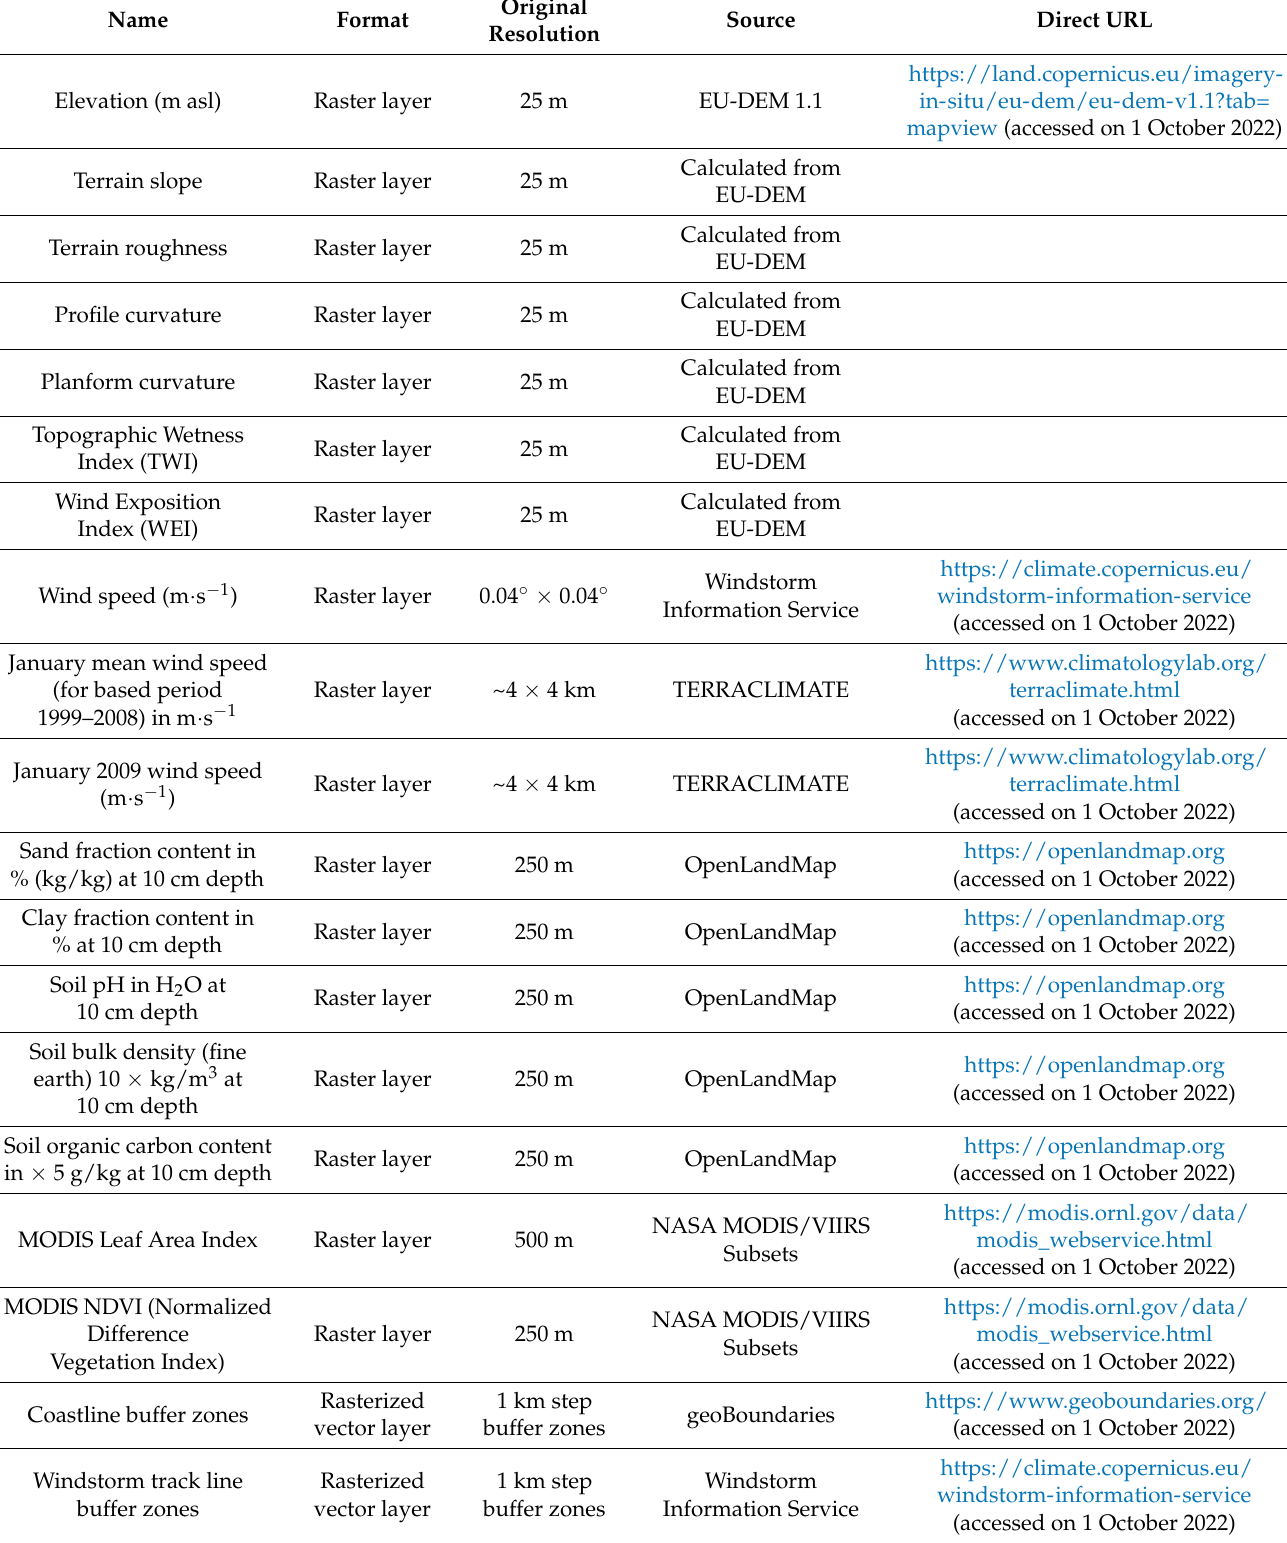
Table 1. List of potential predictors used in the present